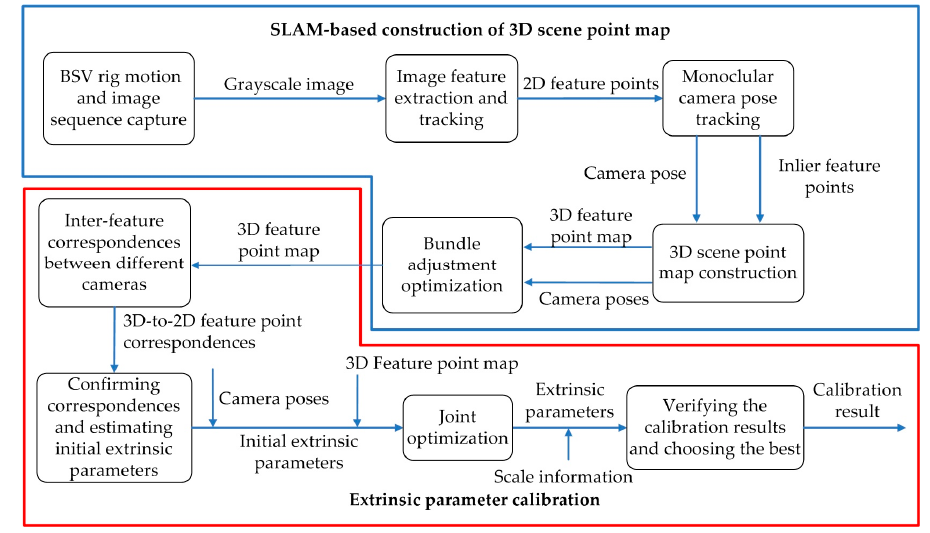
Figure 1. Simultaneous localization and mapping (SLAM)-based self-calibration pipeline which estimates the extrinsic parameter of the binocular stereo vision (BSV) rig.